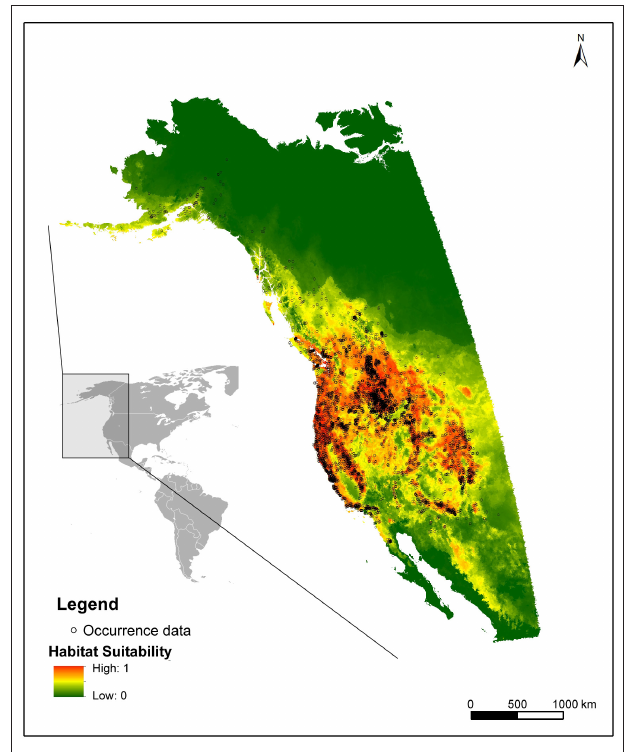
FIGURE 1 | Occurrence data and the output of the habitat suitability map of Oncorhynchus mykiss in calibration phase. GBIF Occurrence Download.